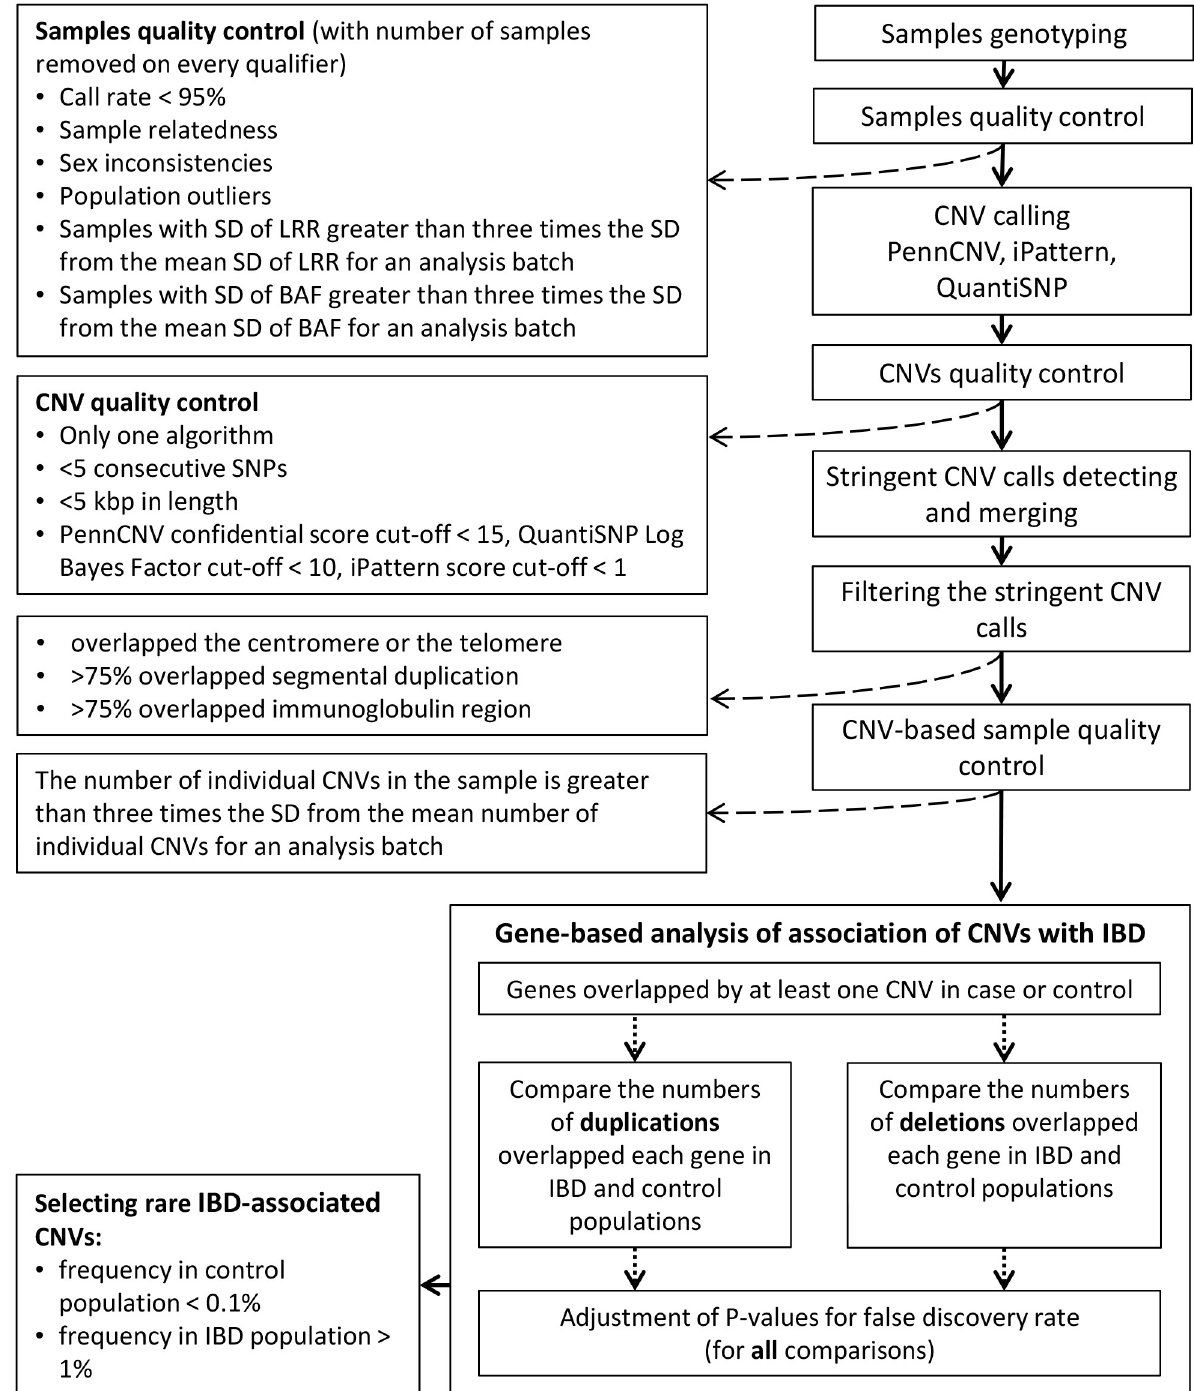
Fig 1. CNV analysis workflow. CNV calling was conducted using variants detected by two or three calling algorithms, which were of sizes greater than 5 kb and spanned at least five array probes. SD: Standard deviation; LRR: Log R ratio; BAF: B allele frequency.